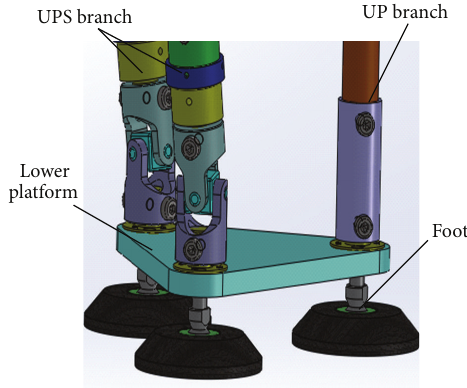
Figure 4: 2-UPS+UP PM and